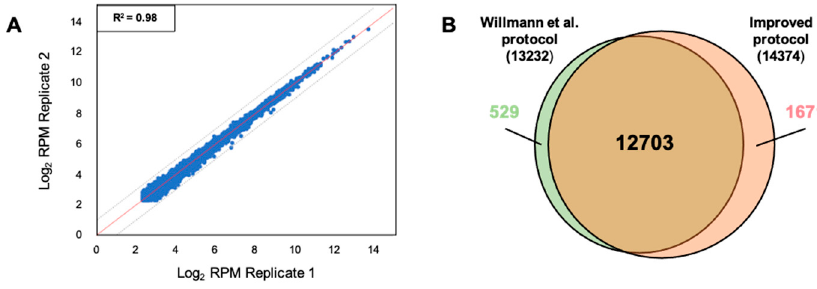
Figure 5 . 5 ′ P degradome libraries are highly reproducible. ( A ) Correlation between read counts (rpm) obtained in replicate 1 versus replicate 2. ( B ) Transcripts identified in degradome library (RPM > 5) using Willmann et al. protocol (N = 13,232) and our protocol (N = 14,374).